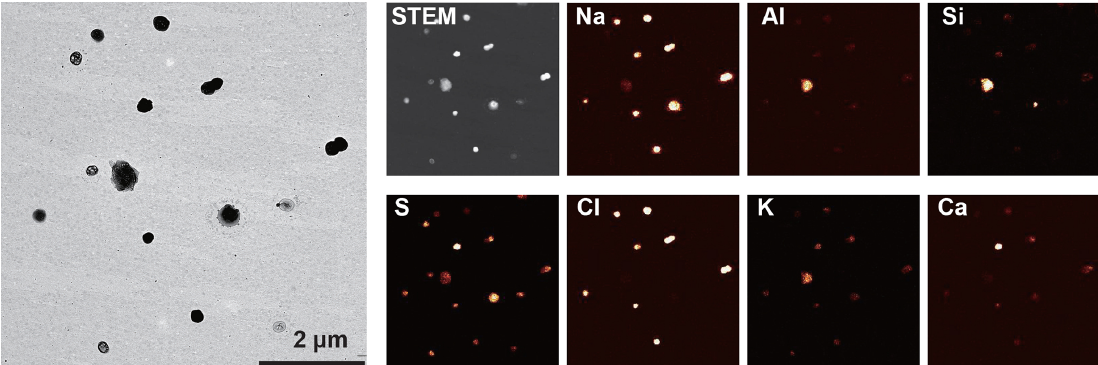
Figure 3. TEM (left) and elemental mapping images (right) of a cloud residual sample collected on 12 November 2018 (07:30). The sampling temperature was − 12 ◦